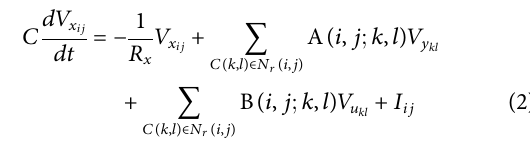
Frontiers in Physics |